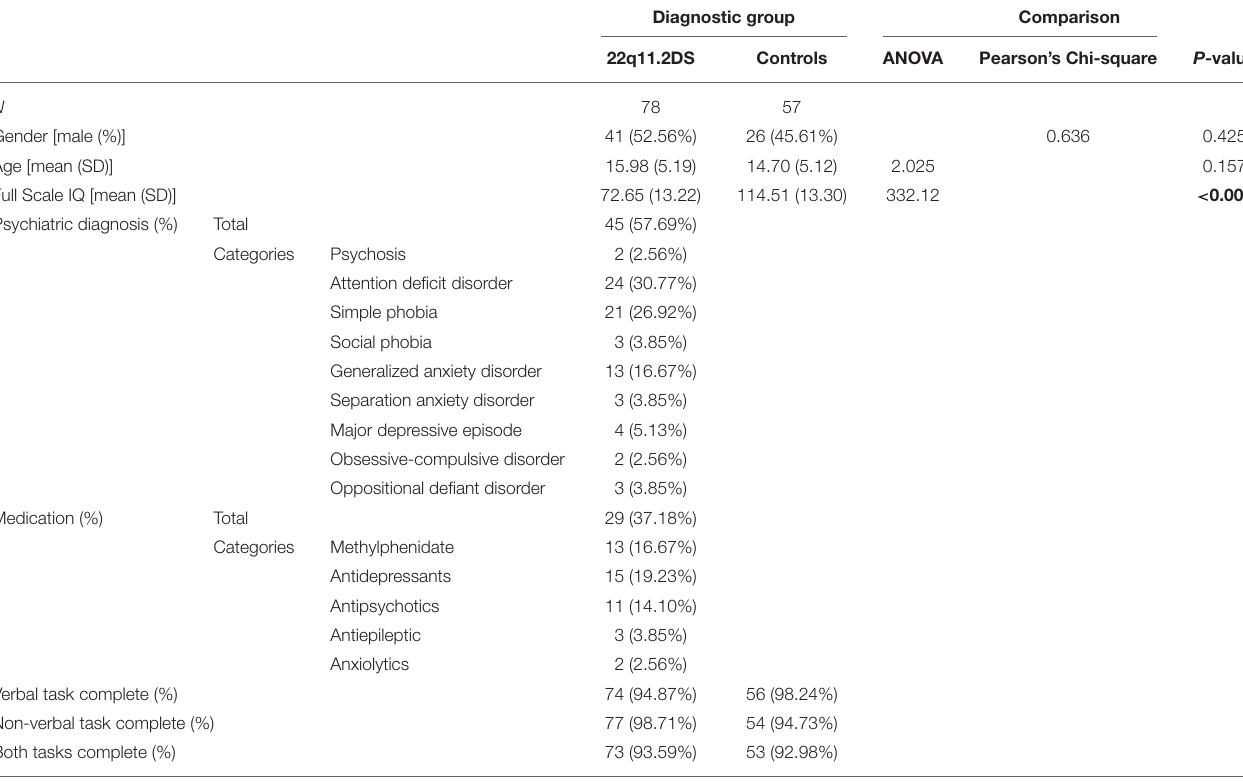
TABLE 1 | Participant